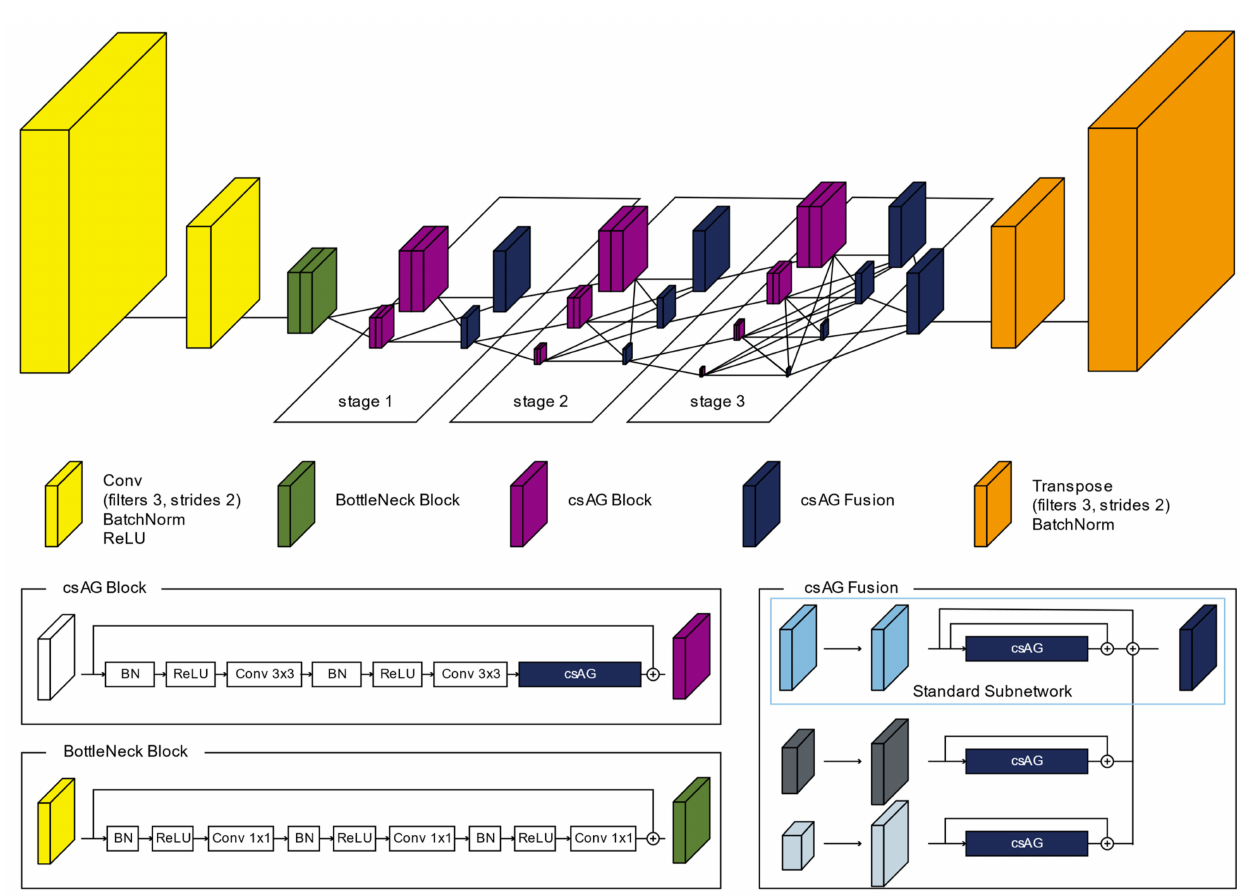
Figure 5. Architecture of the csAG-HRNet